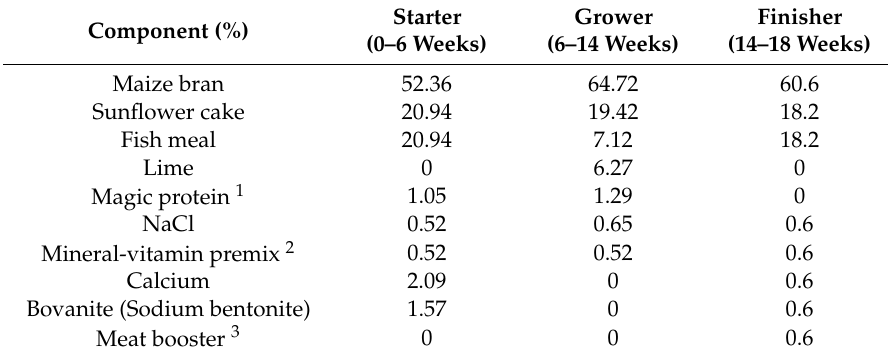
Table 1. Composition of feed